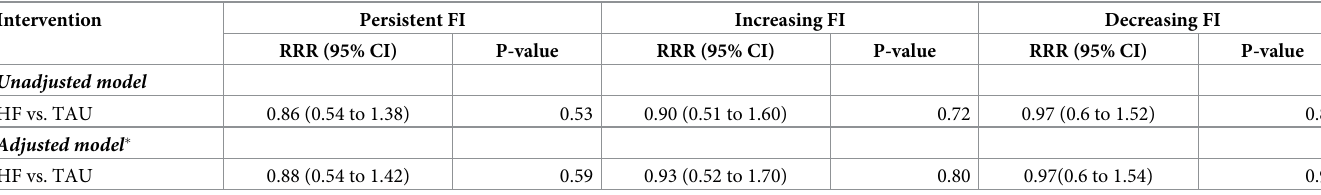
Table 3. Effect of Housing First intervention on Food Insecurity (FI) trajectory group